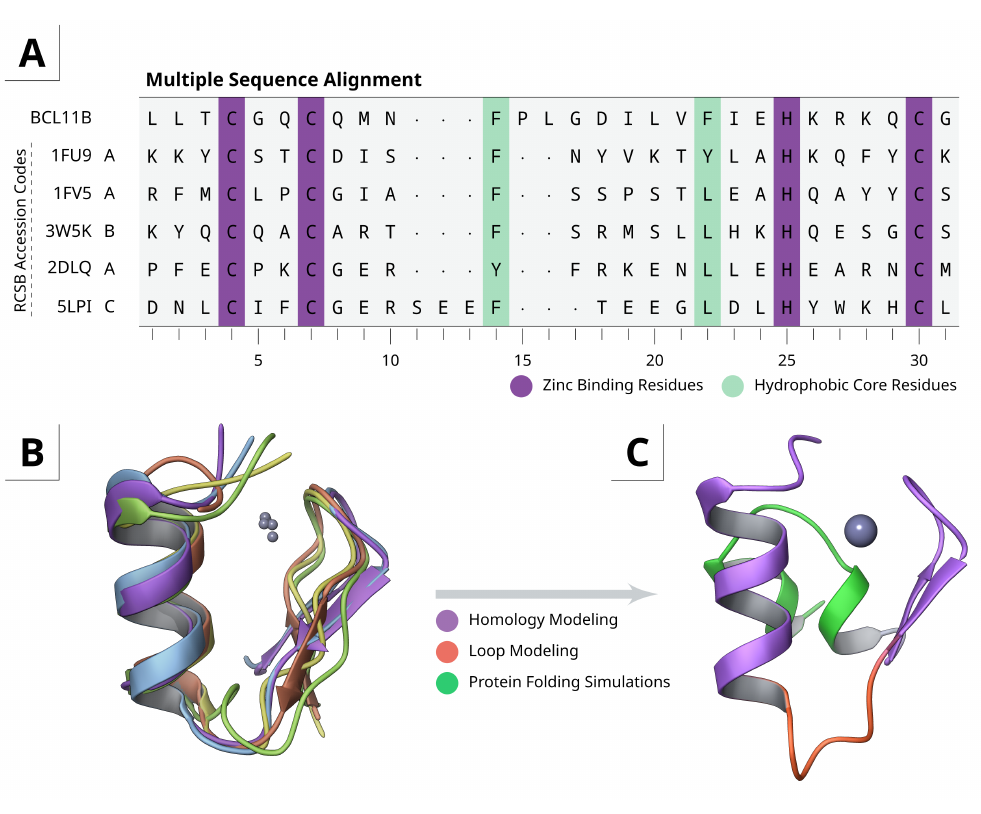
Figure 1. ( A ) Multiple sequence alignment of known CCHC-ZF with important residues highlighted in purple and light green. ( B ) Structural alignment shows a high degree of similarity and the classical ββα -fold for all of them. ( C ) Final model after homology modeling, loop refinement (orange) and replica-based protein folding simulations